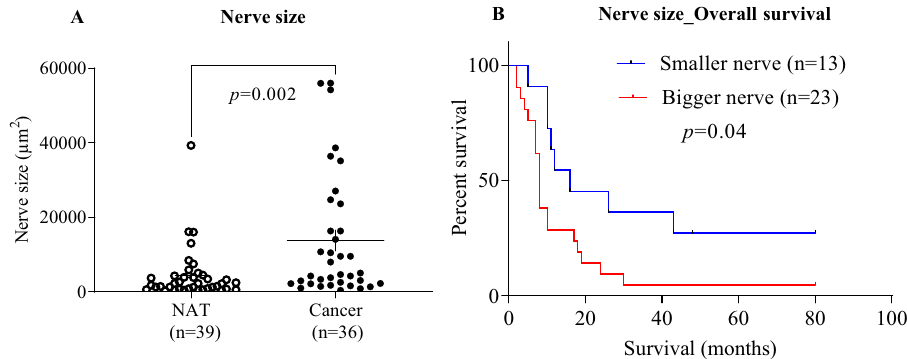
Figure 4. Increased nerve size is associated with pancreatic malignancy and patient survival. Pancreatic tissue sections from PC and normal adjacent tissue (NAT) were analyzed for changes in nerve size (measured by cross- sectional area). The nerve size was bigger in PC tissue than NAT ( A ). The median value of nerve area was taken as cut-off to define two groups (bigger nerve, nerve area bigger than median value and smaller nerve, nerve area smaller than median value) and used for the Kaplan–Meier analysis and the log-rank test. Bigger nerves in the tumor microenvironment was associated with worse patient survival ( B ). Survival analyses displayed a significantly shorter survival for patients with bigger nerve size than that of smaller nerve size. The results of comparative analyses are presented in Table 4A,B. PC pancreatic